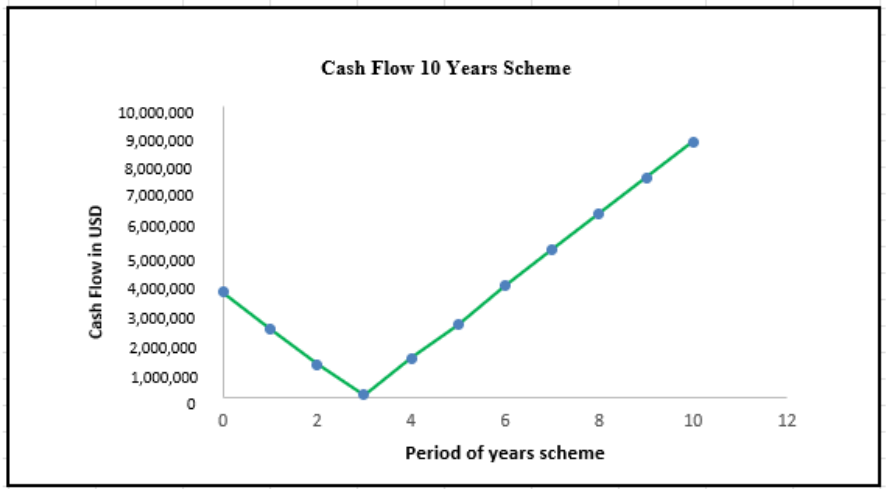
Figure 12. Cash flow for 10 years scheme.